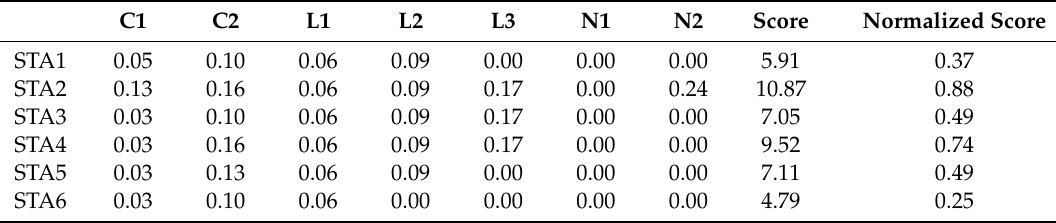
Table 13. Criticality Attributes